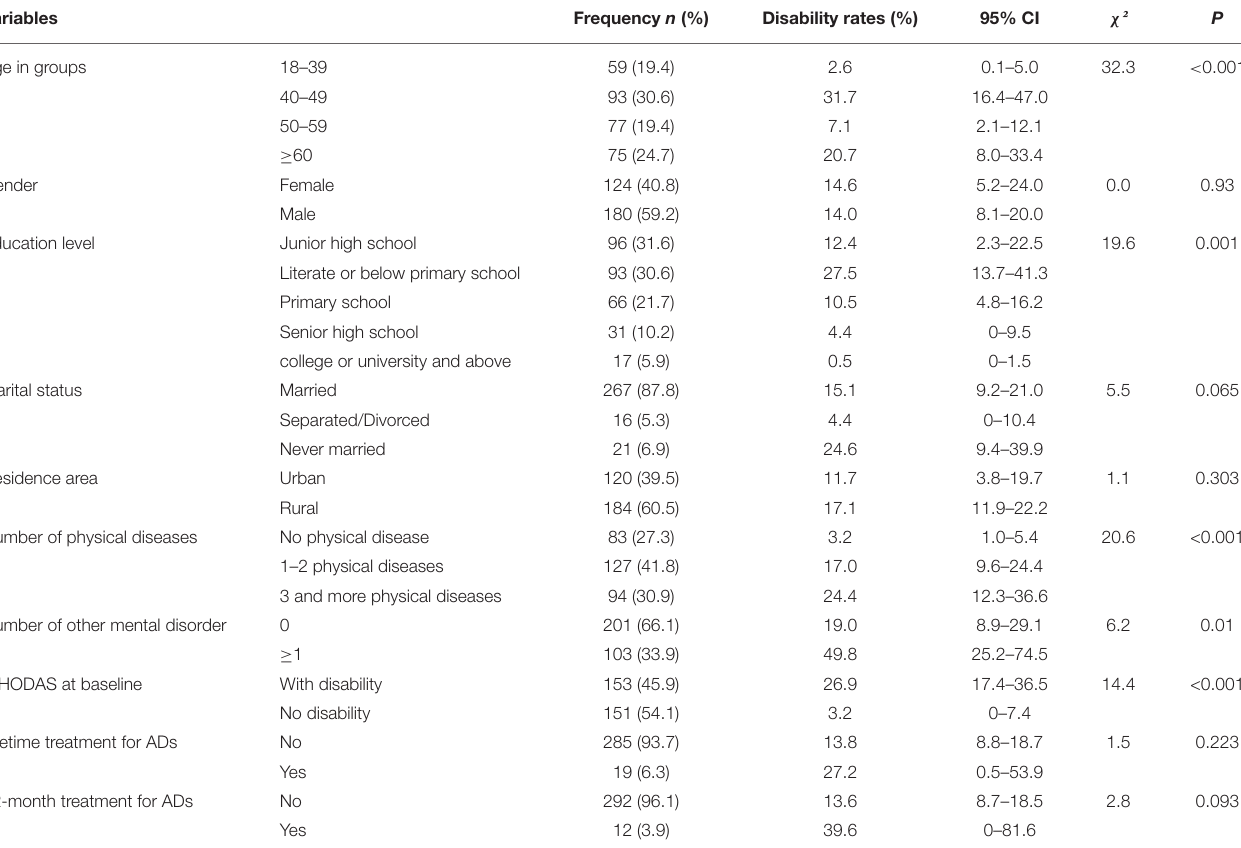
TABLE 2 | The disability rates in different categories of demographic and clinical characteristics status and chi-square test results.